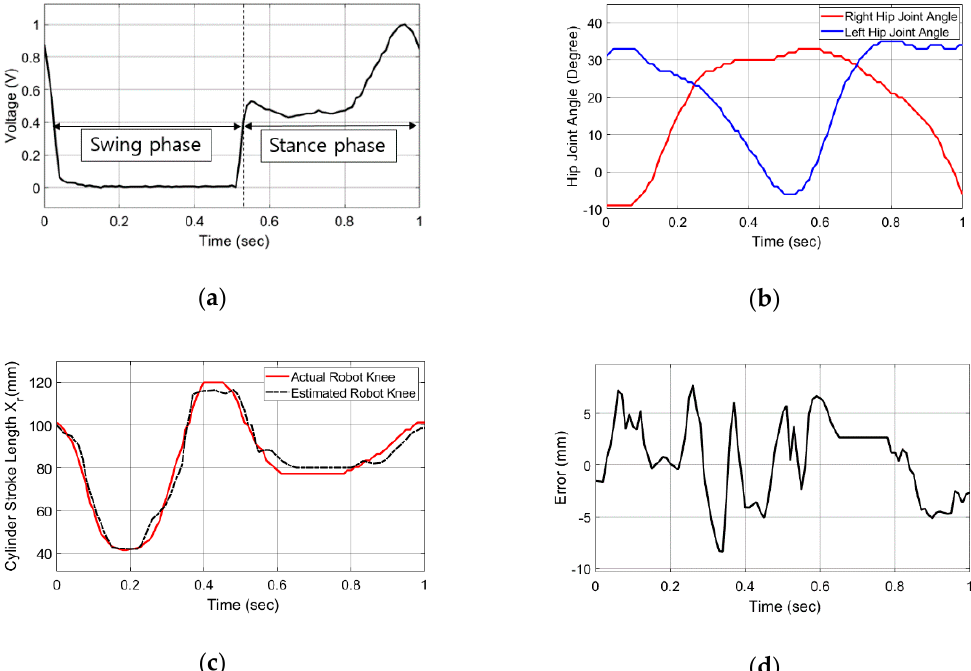
Figure 6. Simulation results of the proposed algorithm for estimating the knee joint angle: ( a ) the summed plantar pressure sensors for distinguishing the gait phase, ( b ) the crisp inputs of the hip joint angles, ( c ) the comparison of the estimated robot knee and the actual robot knee, and ( d ) the measurement error between the estimated output and the actual output. Table 1. Fuzzy rules set for the swing phase.